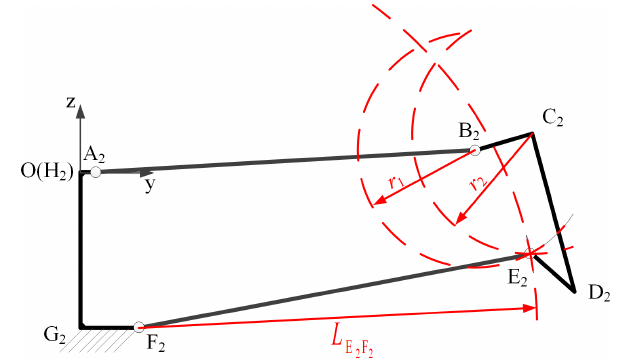
Figure 7. Location solution of point E2 with the drawing method.